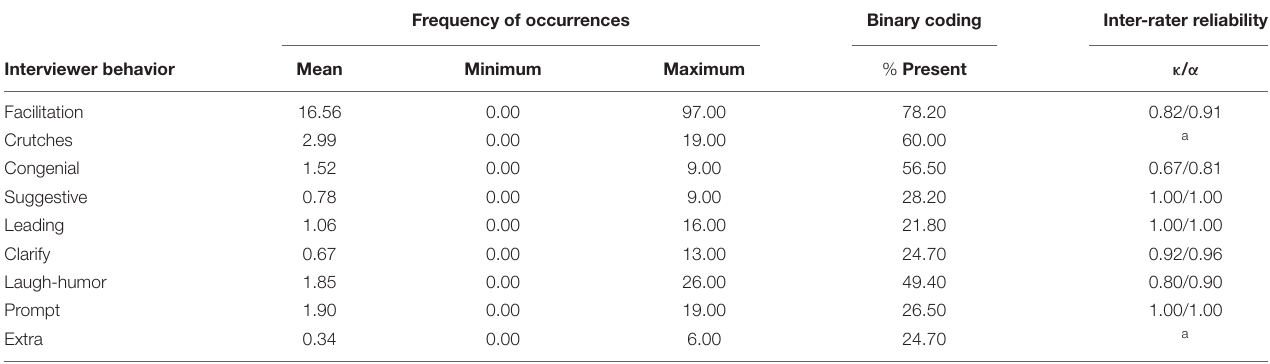
TABLE 3 | The raw data frequency and percentage present of binary coding of the interviewer